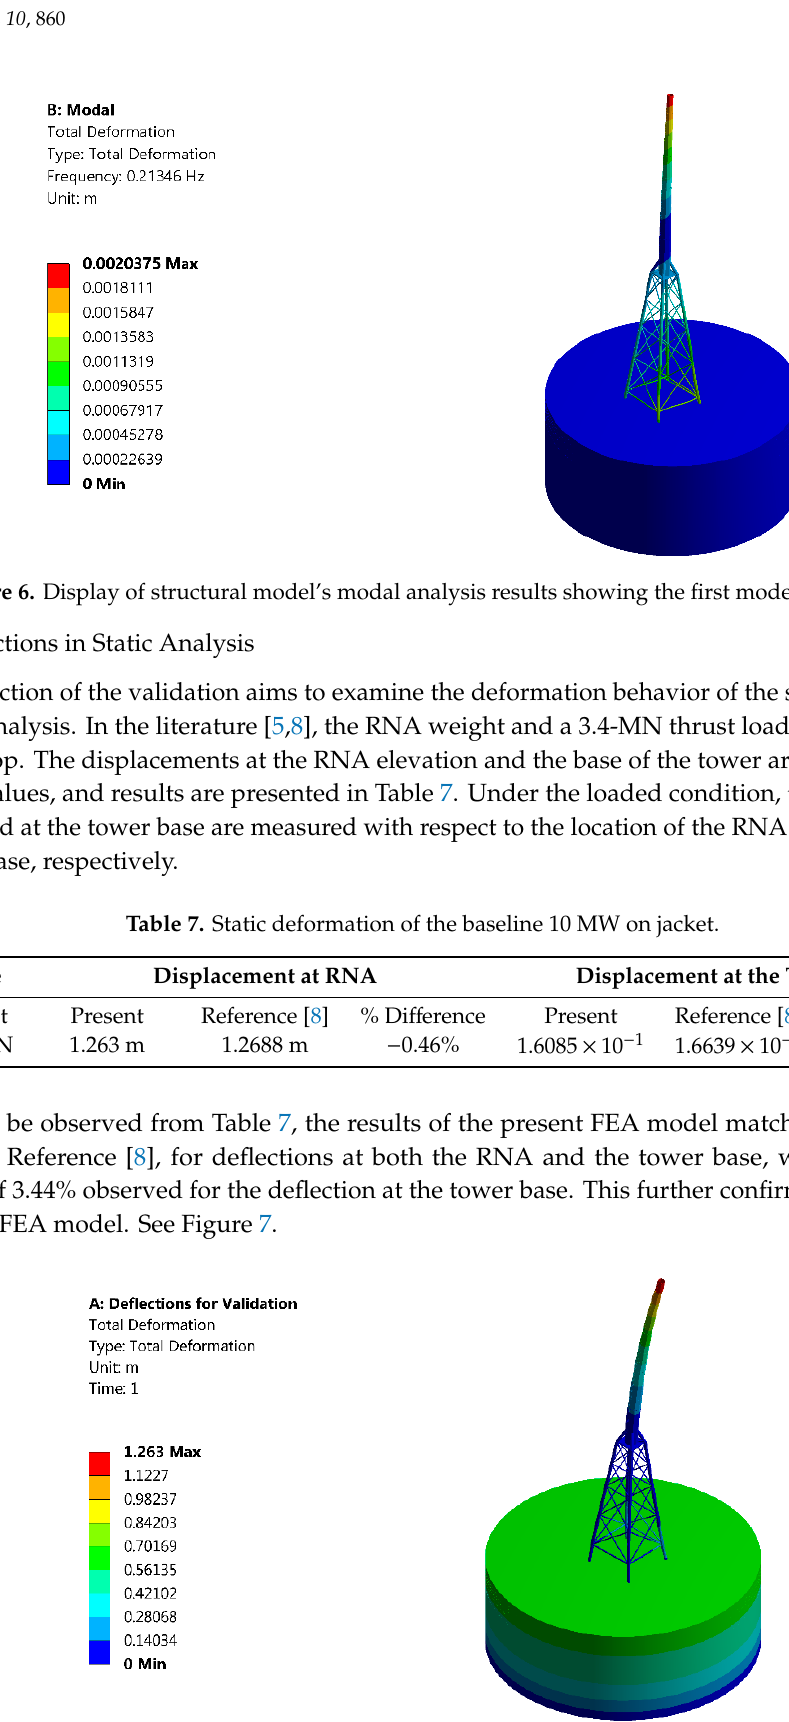
Figure 7. Display of results of total deformation showing the deflection at the RNA level.